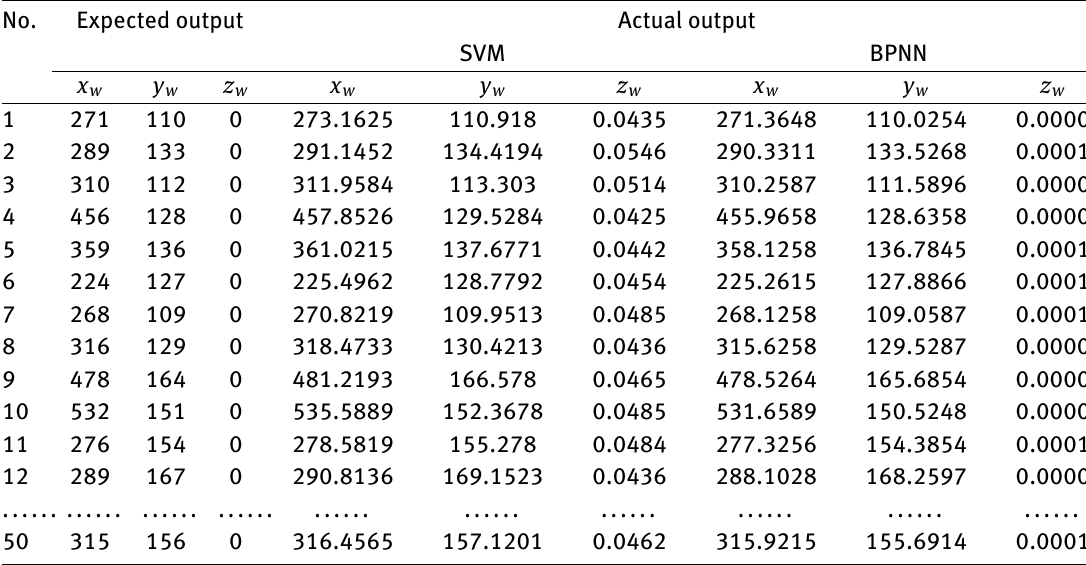
Table 1: Positioning